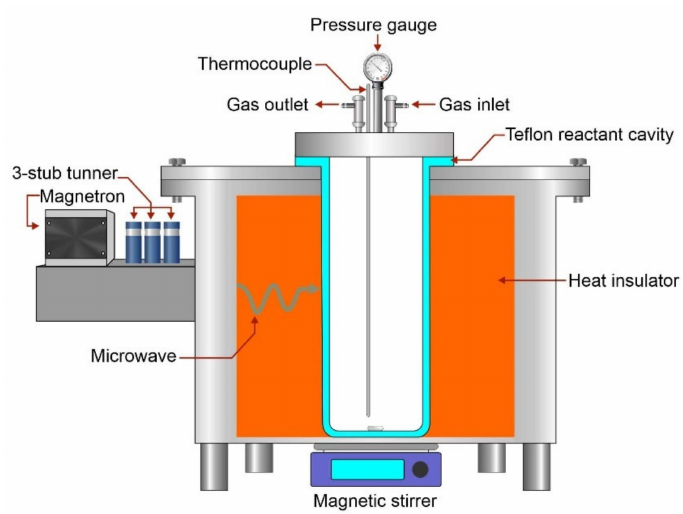
Figure 1. Customized microwave reactor used in this